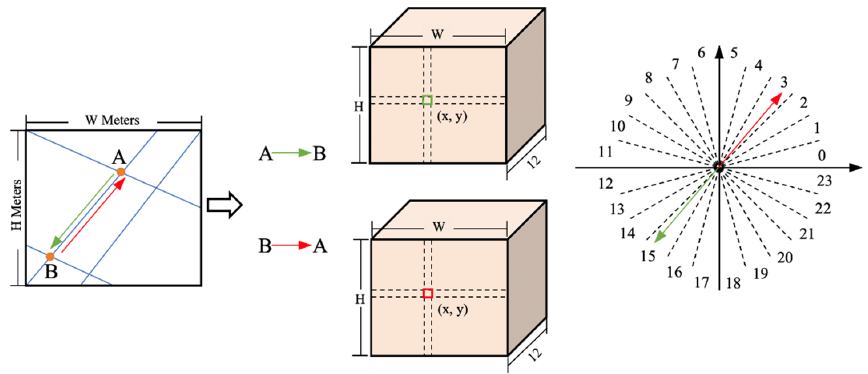
Figure 4. An angular classification method. The interval angle is set to 15, and if the node direction exists, it can be divided into 24 classes. exists, it can be divided into 24